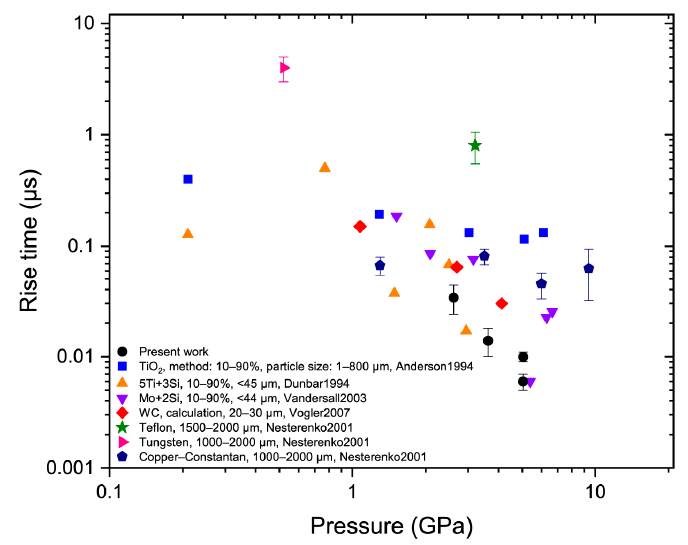
Figure 8. Compaction wave rise time versus pressure. The rise times for nNi are plotted versus the pressure rise only in the compaction wave p 2 − p 1 . Earlier data from [28,29,33,34,41] are also plotted.